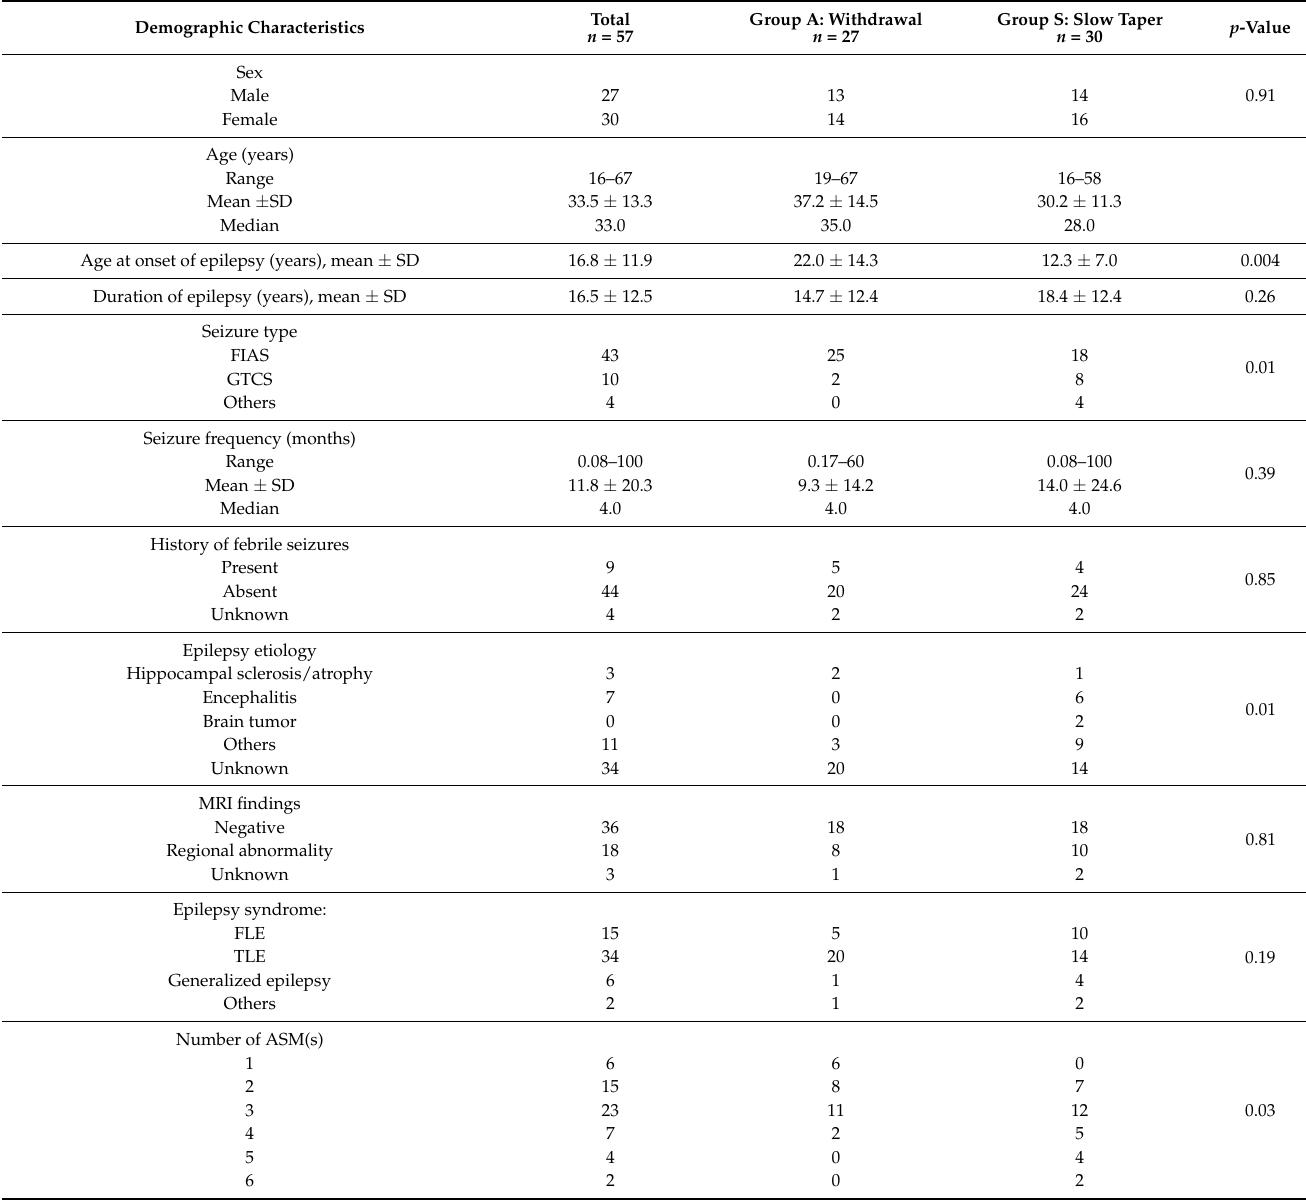
Table 2. Demographic and clinical characteristics of patients ( n =